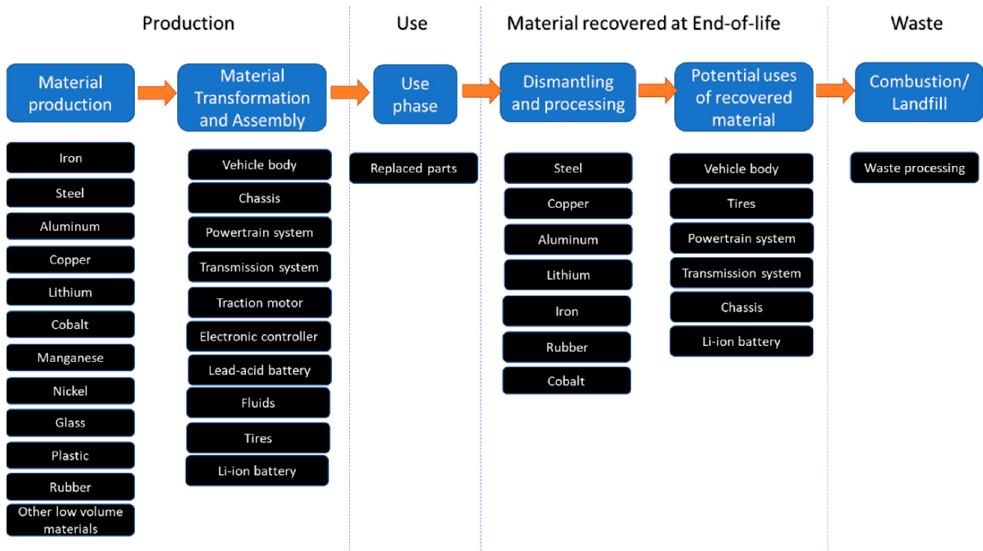
Figure 2. Electric vehicle production to end-of-life.